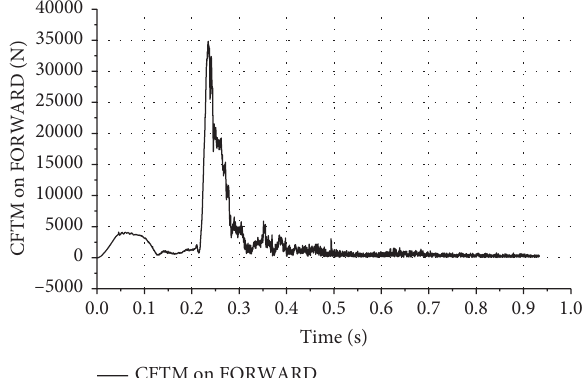
Figure 31: Emergency breaking load of front connection point—course of impact.